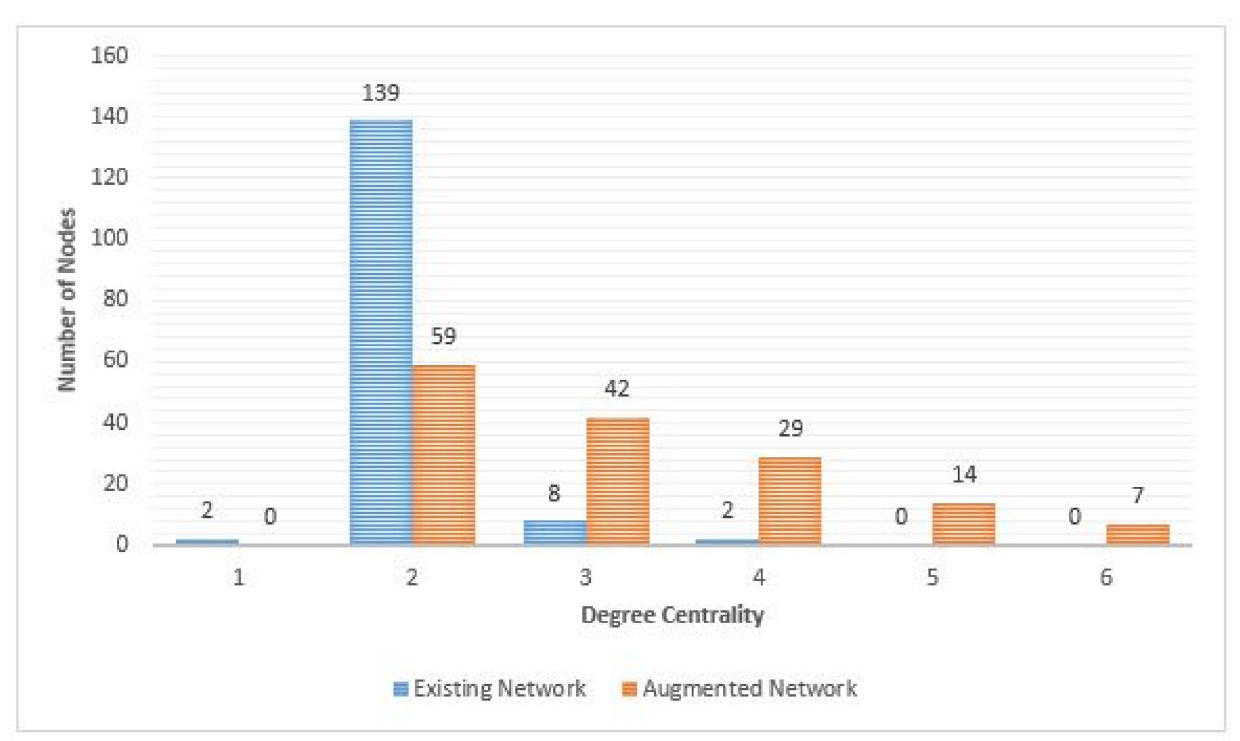
Fig 14. Degree centrality of existing network and augmented